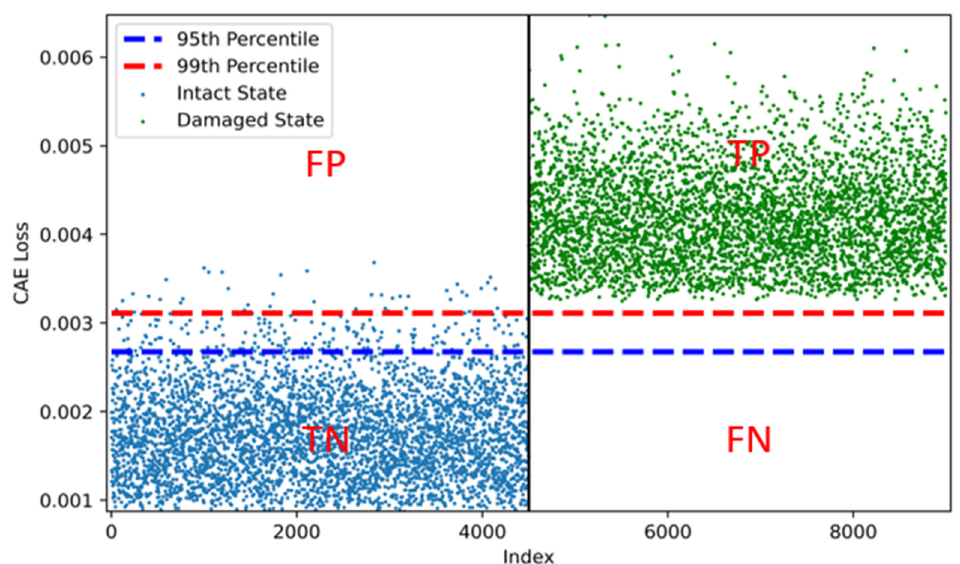
Figure 14. Example of scatter plot of CAE losses for RC-slab-bridge modeling (TP means true and positive. FP means false and positive. TN means true and negative. FN means false and negative. True and false indicates that the CAE model correctly and incorrectly predicted the bridge damage state, respectively. Positive and negative indicate the damaged state and the undamaged state, respectively, as the predicted state by the model.).